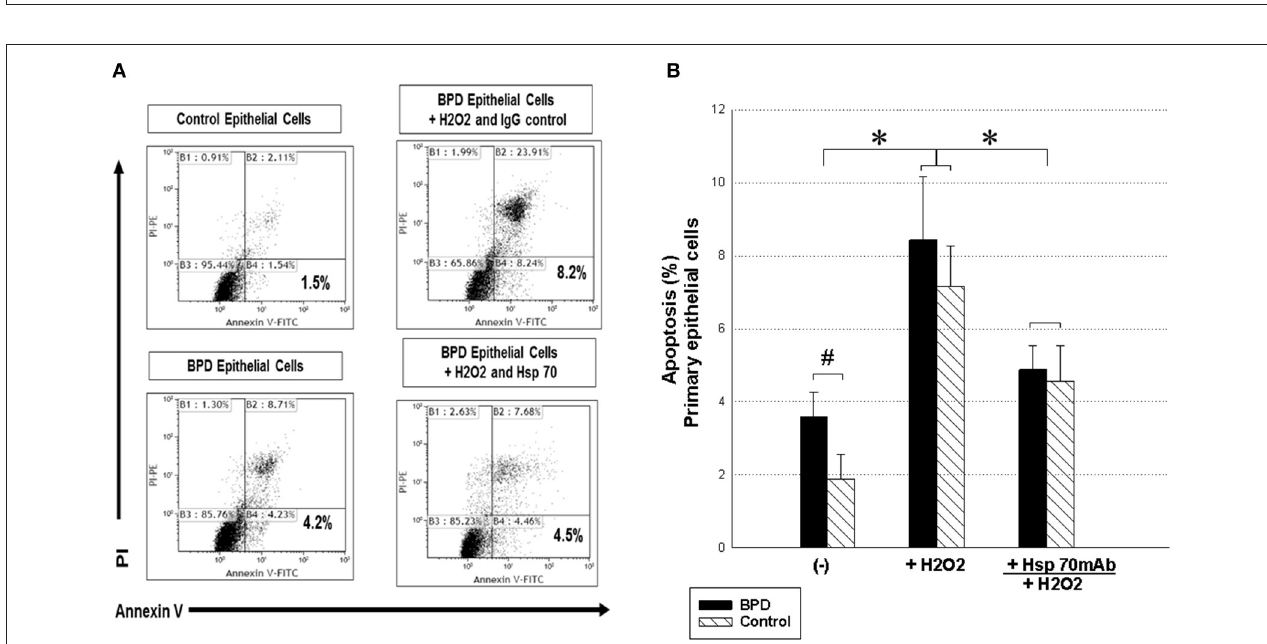
FIGURE 3 | Cutoff values of TA Hsp-70 and 8-OHdG levels discriminate BPD in VLBW preterm infants on post-natal Day 1 (A) and Day 28 (B) of life.